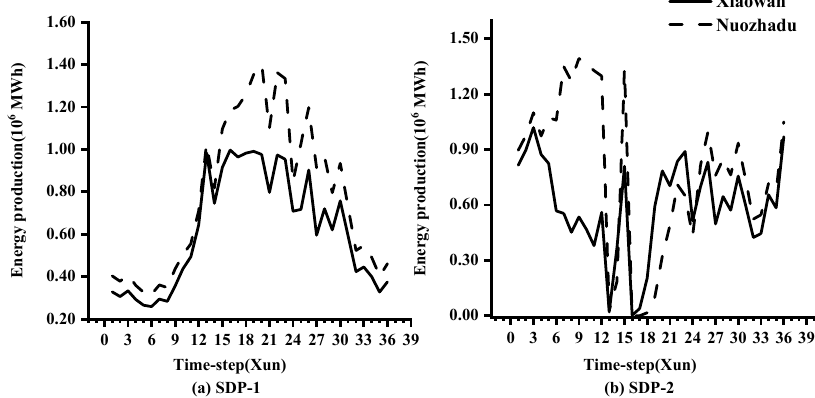
Figure 5. Comparison between the SDP-1 and SDP-2 on average energy production in each Xun (1/3 month).